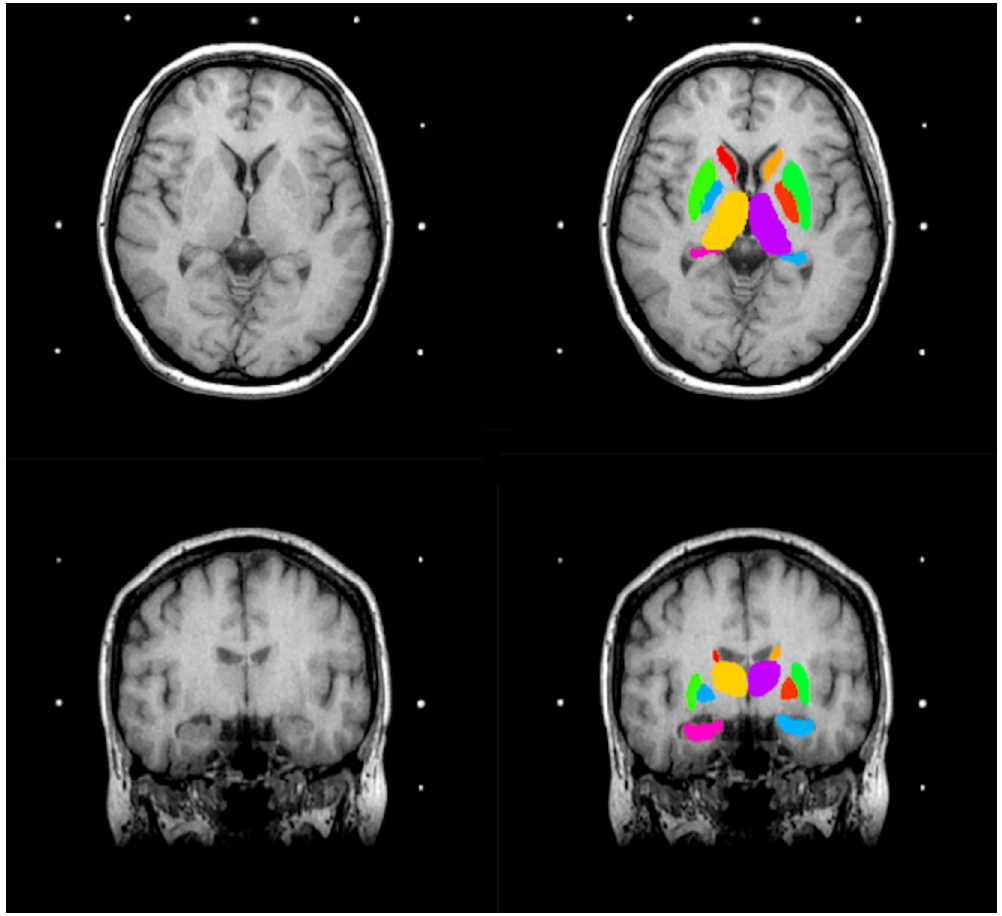
Fig 1. Brain MR images. Axial (top) and coronal (bottom) Brain MR image before (left) and after (right) application of FIRST. The colours correspond to the segmented sub-cortical structures: pink (left hippocampus), light blue (right hippocampus), orange (left thalamus) and purple (right thalamus).